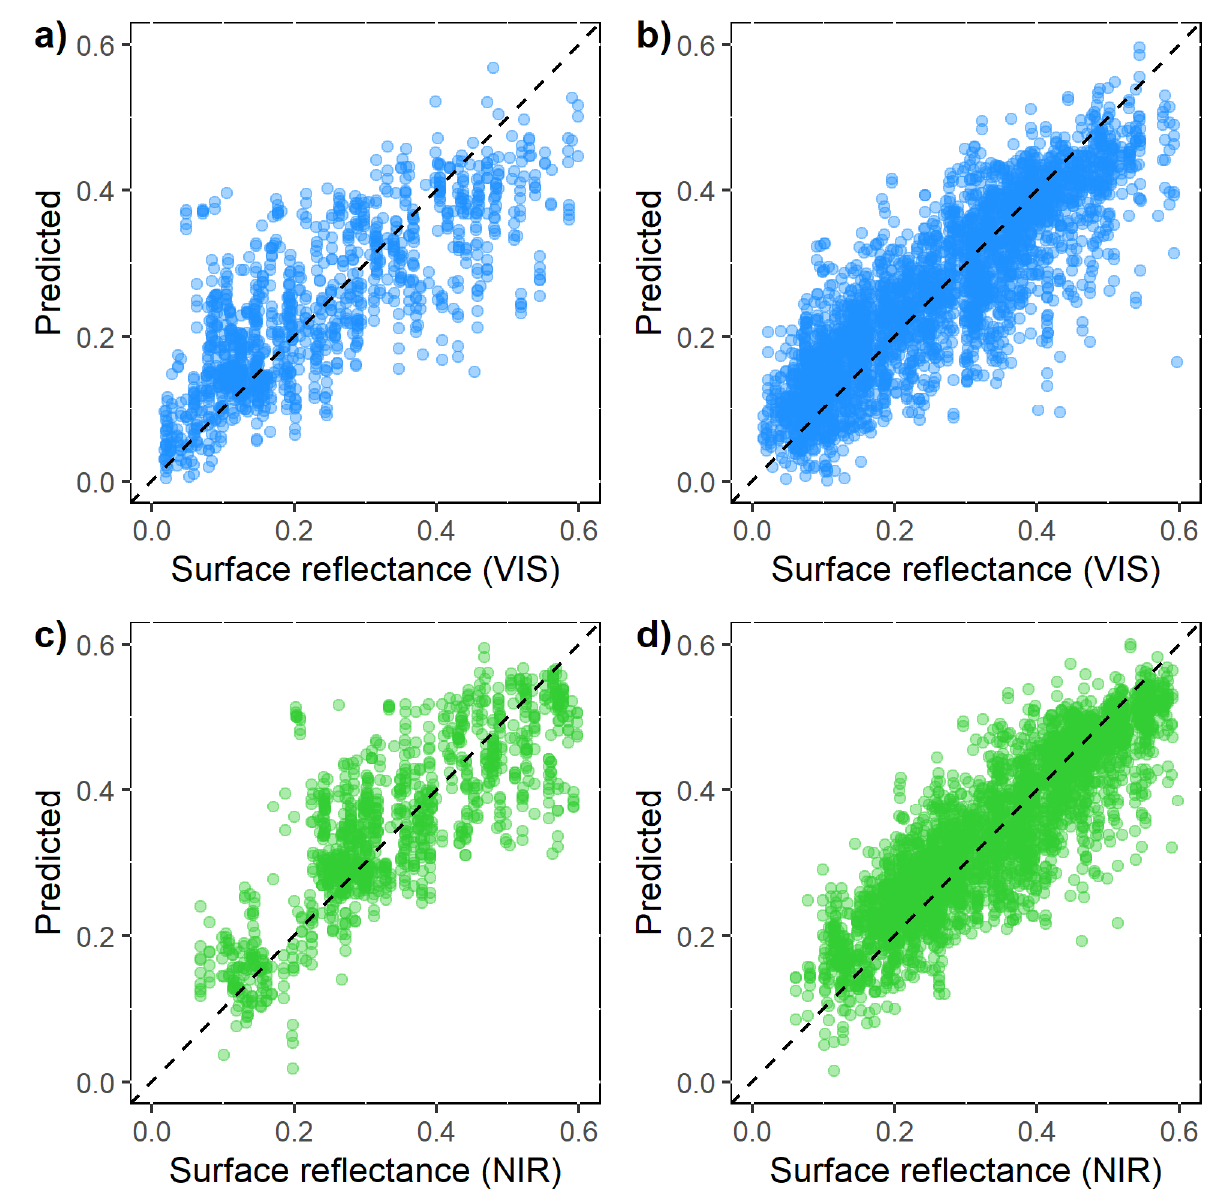
Figure 12. Observed versus predicted surface reflectance based on the best GAM model (highest R-squared values) for visible and near-infrared bands in March scene for deciduous and evergreen forests. The data points clustered around the 1:1 line suggest a good model prediction (fit). Sub-plot ( a , b ) are for deciduous forests, while sub-plot ( c , d ) are for evergreen forests.